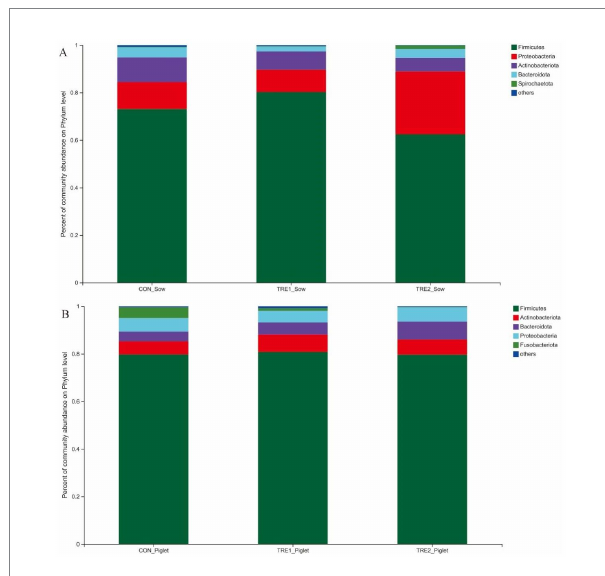
FIGURE 3 Fecal microbiota species of sows and piglets at phylum level among different groups. (A) Fecal microbiota for sows among different groups. Sows are regarded as the experimental units, N = 5 for each